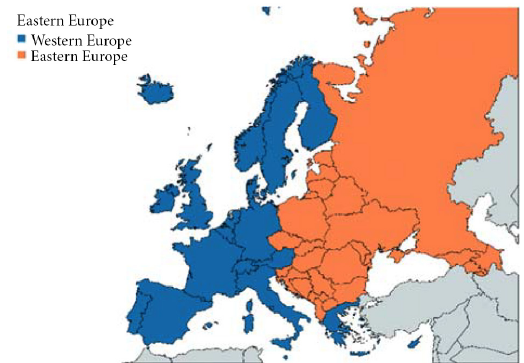
Fig. 2. List of countries distributed into the Eastern- and Western-Europe